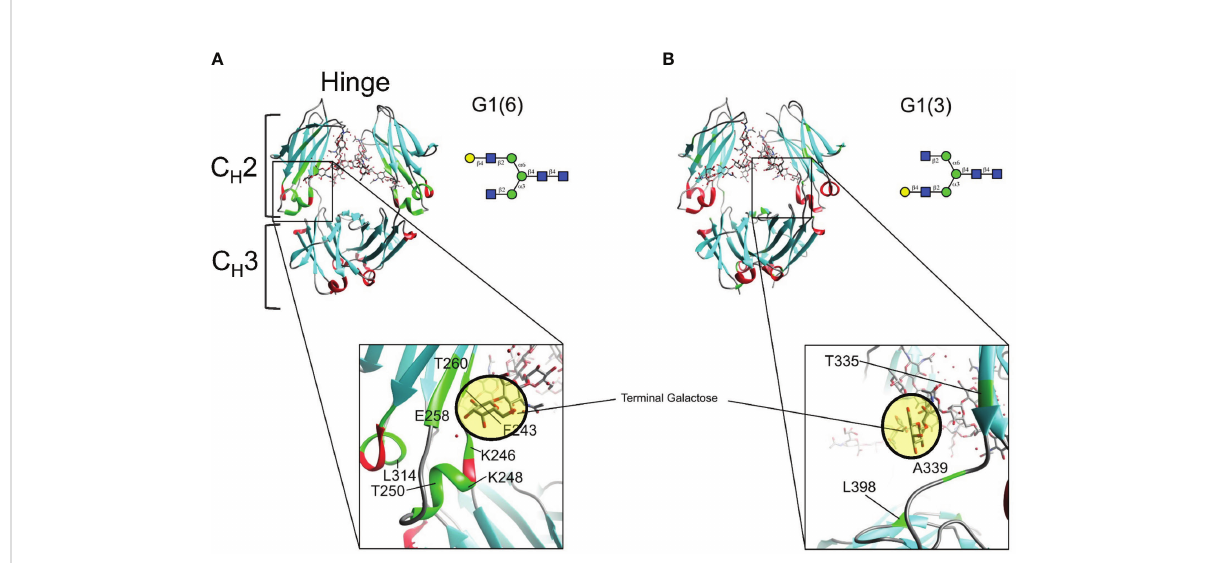
FIGURE 6 Mapping chemical shifts perturbations of Fc glycoproteins bearing a galactose residue at either the a 3- or a 6-antenna. (A) In the a 6-antenna, the galactose is in close proximity with the protein backbone, whereas (B) in the a 3-antenna, the galactose residue is exposed to the outer solvent. Residues that experiencing chemical shift perturbations are depicted in green. b -sheets are depicted in cyan, a -helix in red, and loops/ turns are shown in gray. X-ray structure of glycosylated Fc (PDB ID: